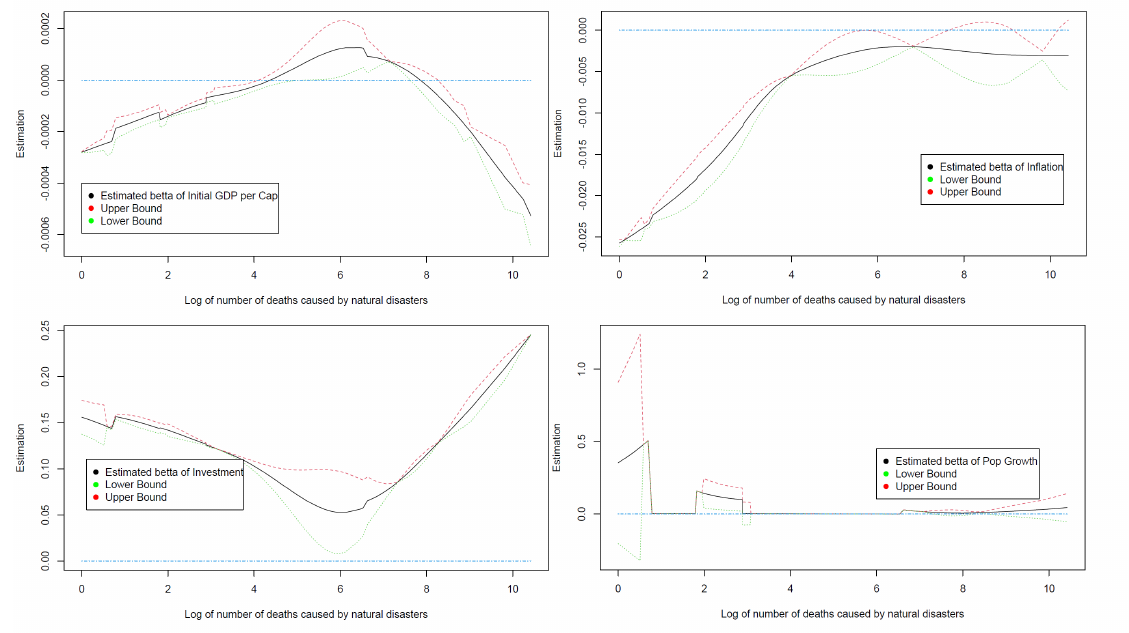
Figure 2. Smooth coefficient with fixed effects model using deaths due to exposure to forces of